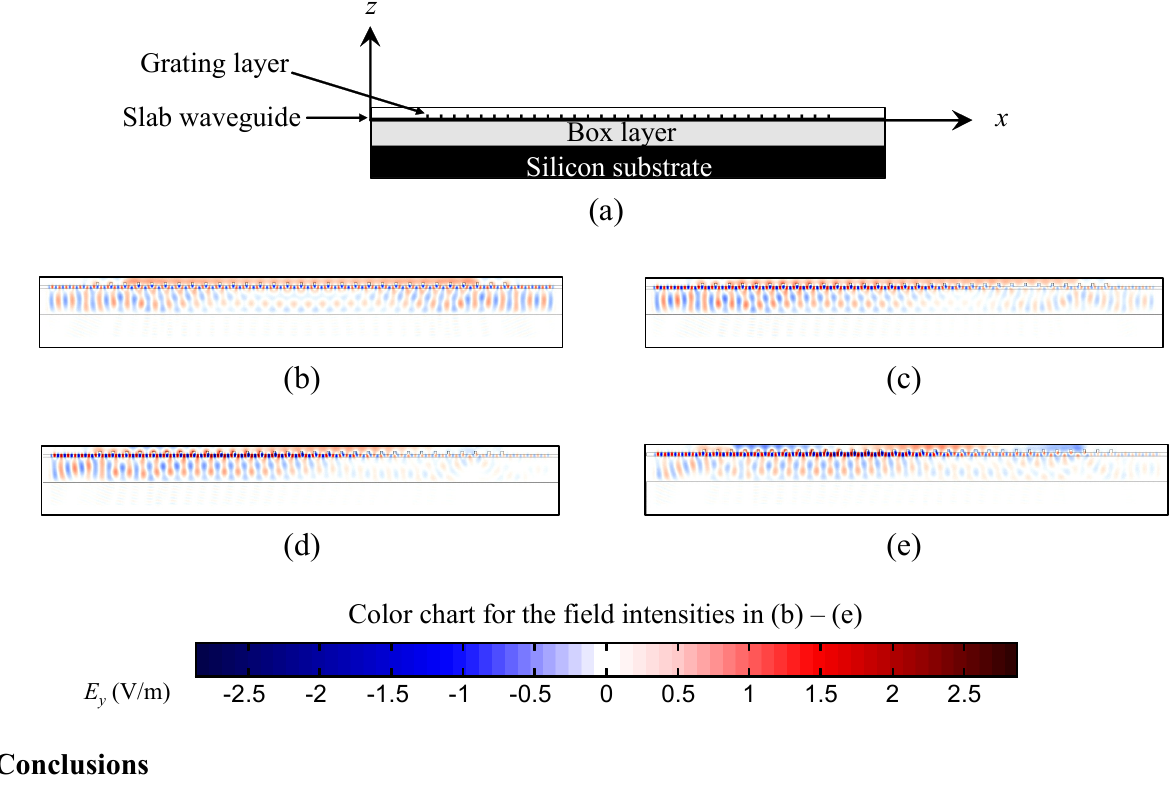
Figure 6. Field distribution plots with four different incident angles. ( a ) Device configuration. ( b ) Field distribution plot with θ = 1°. ( d ) Field distribution plot with θ θ inc